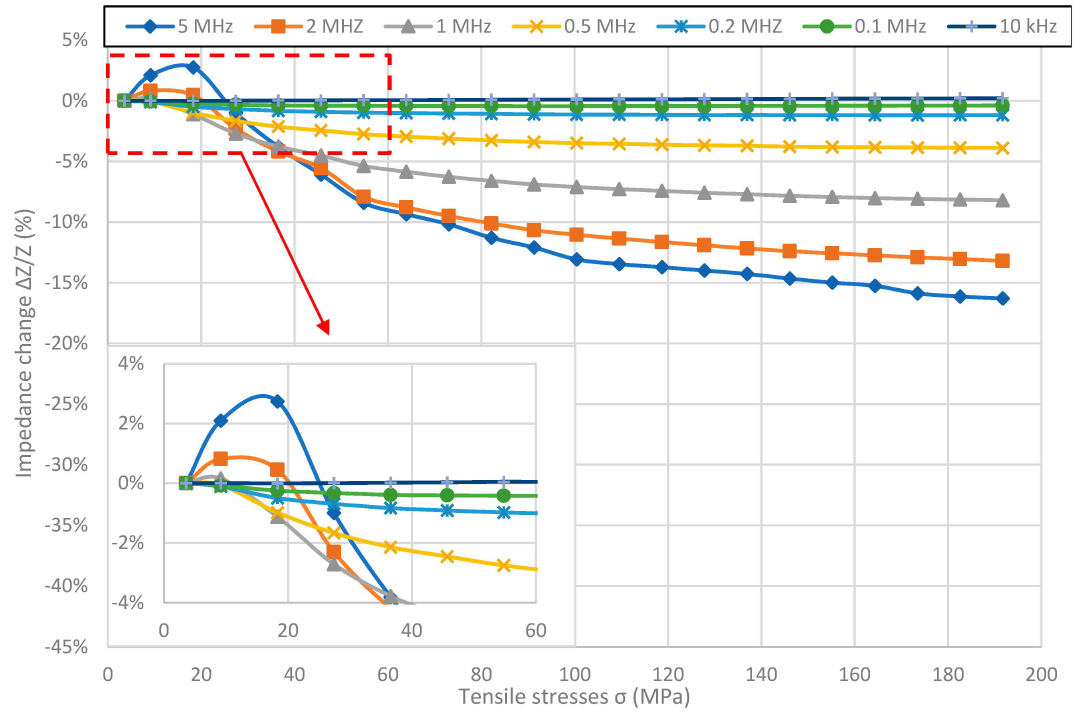
Figure 3. Dependence of sample Fe 40 Ni 38 Mo 4 B 18 impedance on tensile stress σ